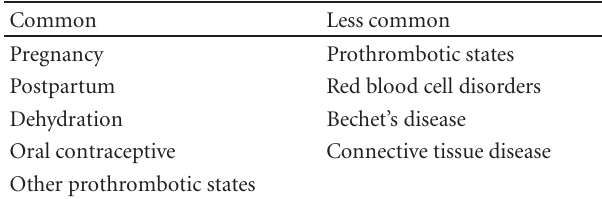
Table 3: Causes of stroke in